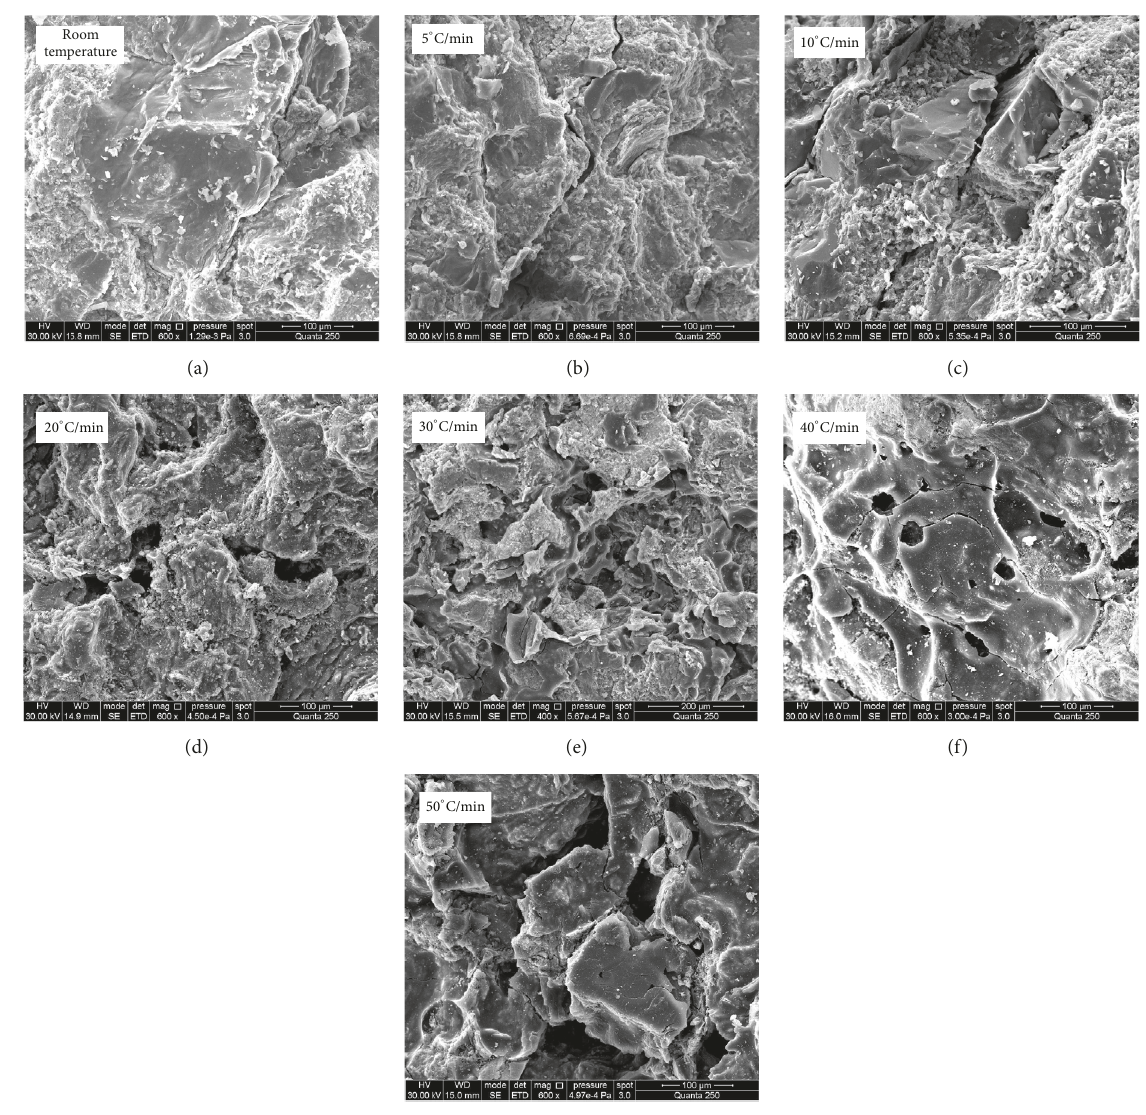
Figure 11: Microscopic features of the